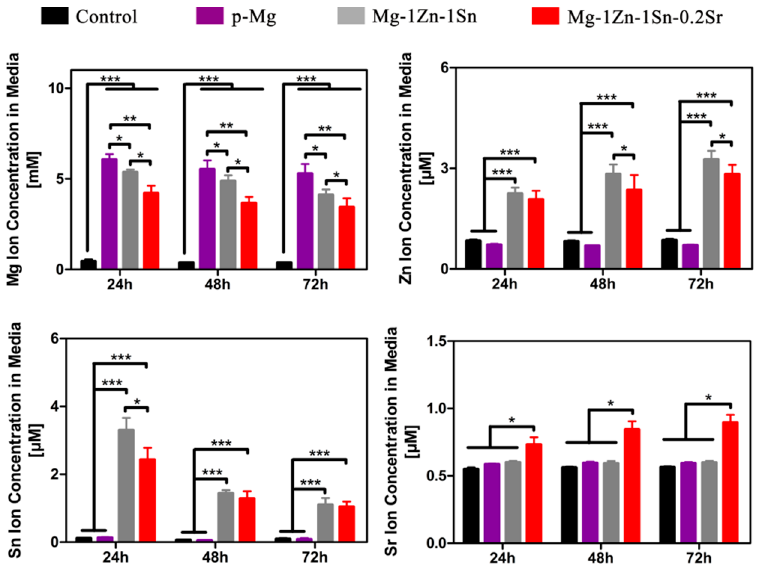
Figure 8. Mg, Zn, Sn and Sr ion concentrations in culture medium incubated with the samples during a 72 h period. n = 3 for all groups and time points. Values are mean ± SD. * p < 0.05, ** p < 0.01, *** p < 0.001.